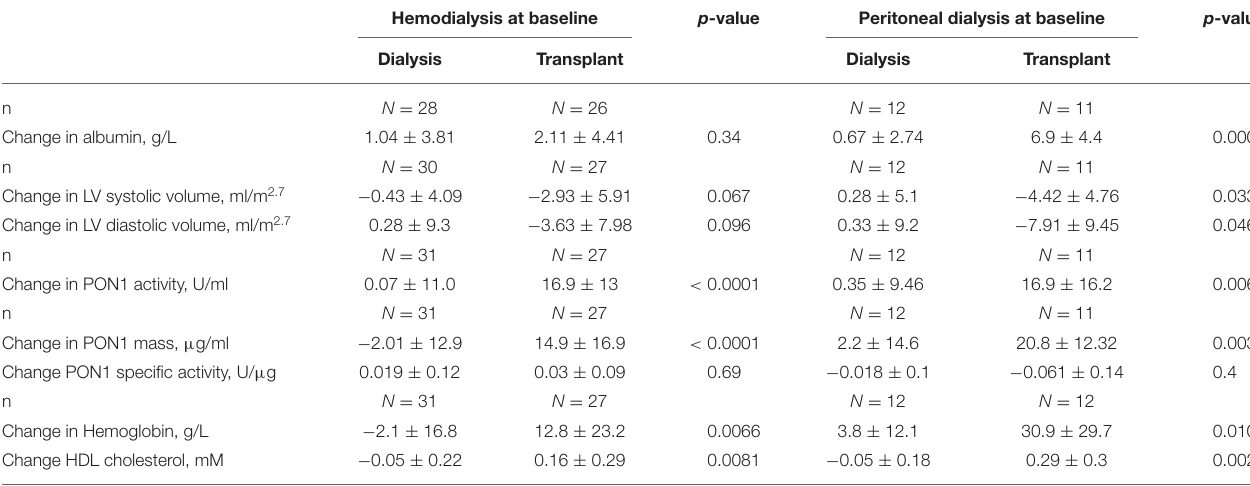
TABLE 3 | Change in paraoxonase-1 mass and activity and relationship with hemoglobin and albumin by baseline dialysis modality. Hemodialysis at baseline p -value Peritoneal dialysis at baseline p -value Dialysis Transplant Dialysis Transplant